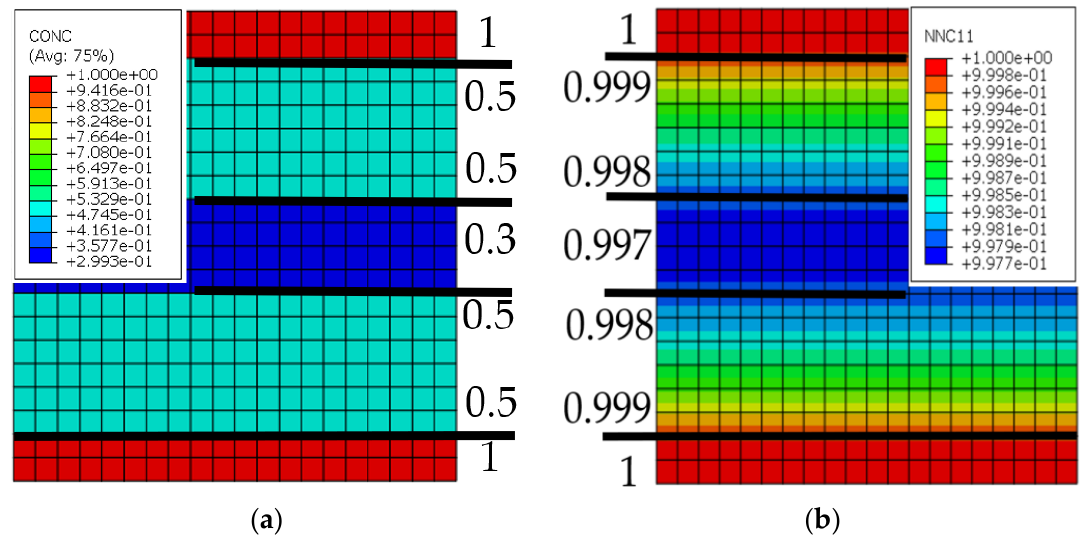
Figure 8. The details of finally concentration distribution of sandwich structure: ( a ) Concentration distribution; ( b ) Normalized concentration distribution.